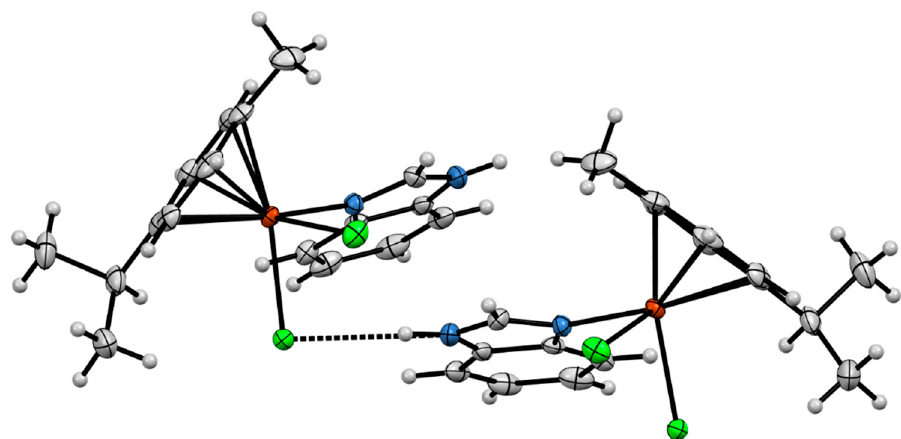
Figure 6. Intermolecular N–H···Cl interactions in the crystal structure of complex 3